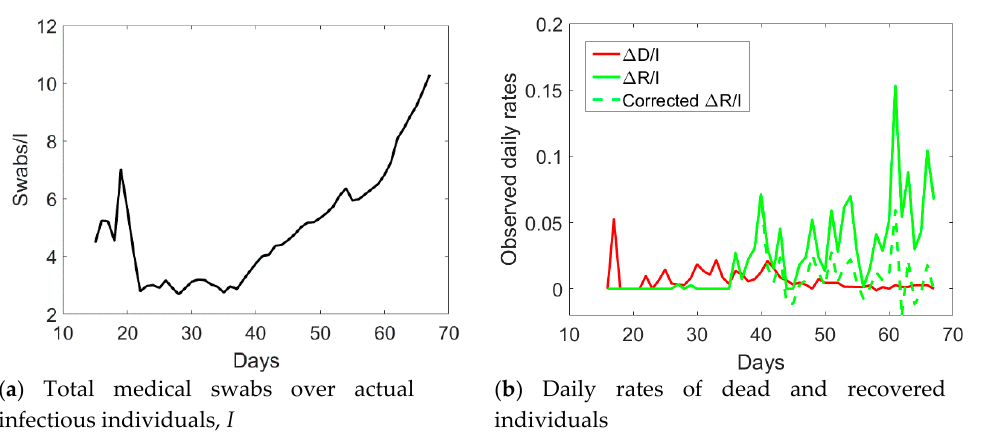
Figure 4. Ratio between the total number of medical swabs and the actual number of infected individuals, I ( a ), and daily rates of dead and recovered individuals ( b ) in Valle d’Aosta from 24